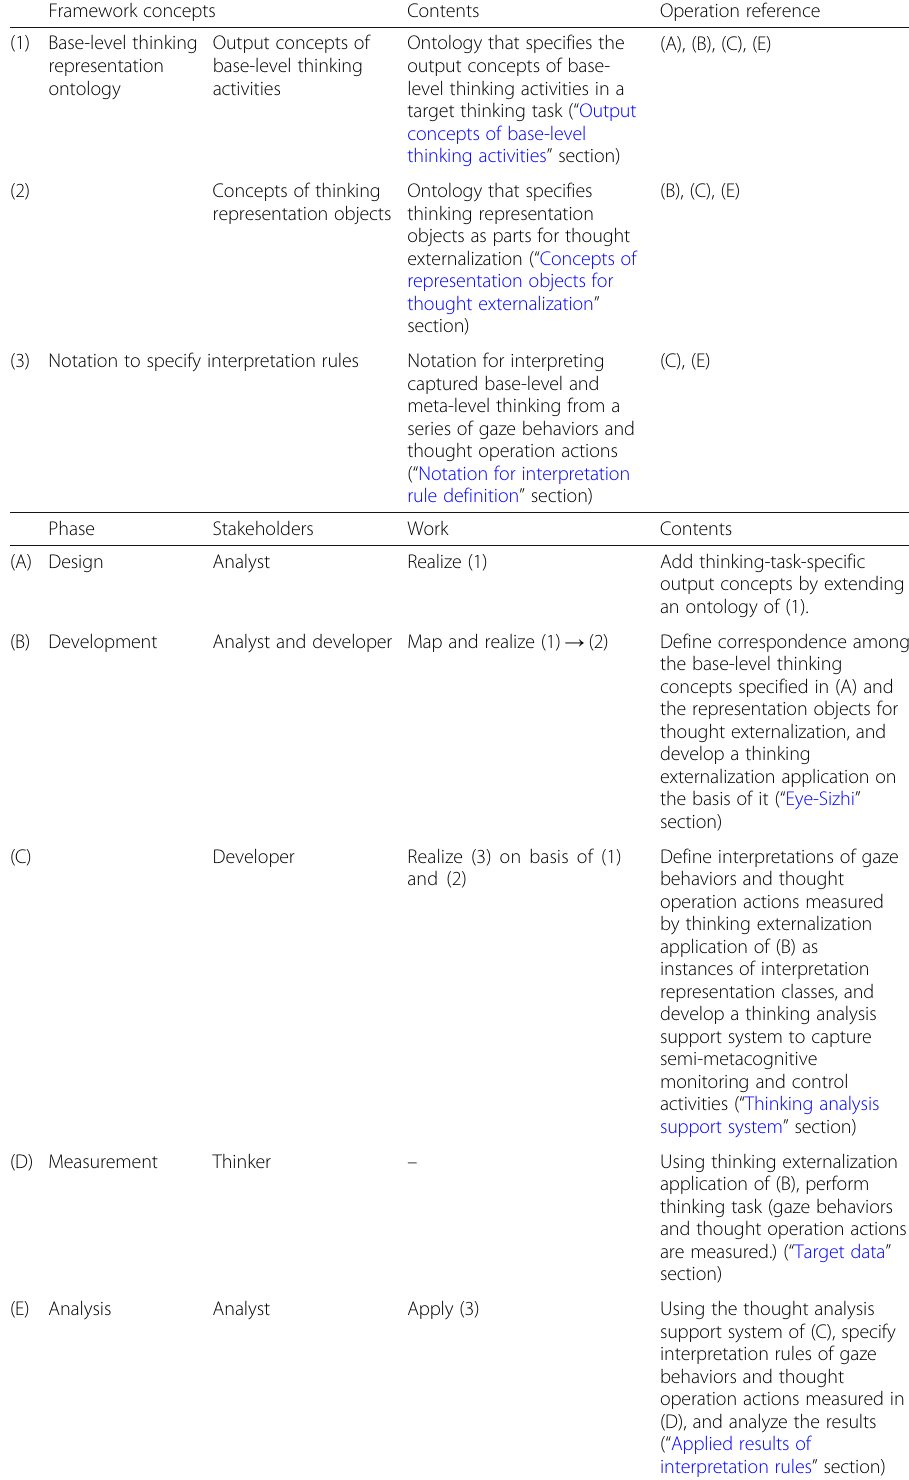
Table 1 Interpretation framework to capture meta-level thinking